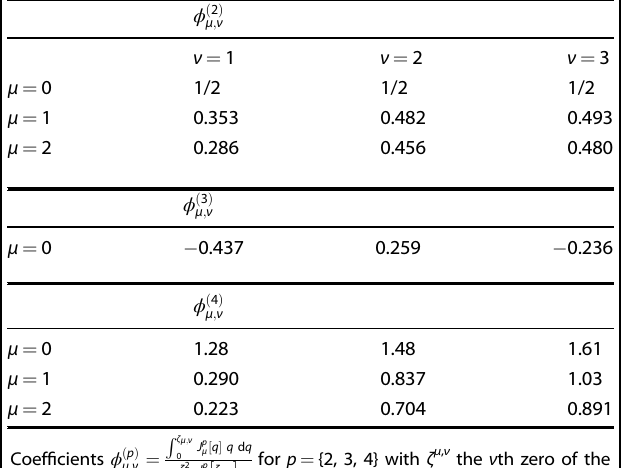
Table 2. Coef fi cients in (non)linear super fl uid spring